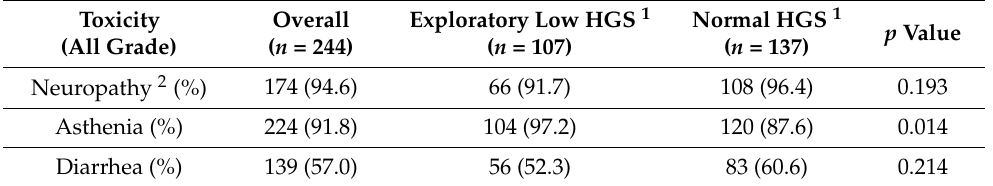
Table 5. Association between low handgrip strength on median-based analysis (exploratory low HGS) and all-grade chemotherapy-induced toxicities (dose-limiting and